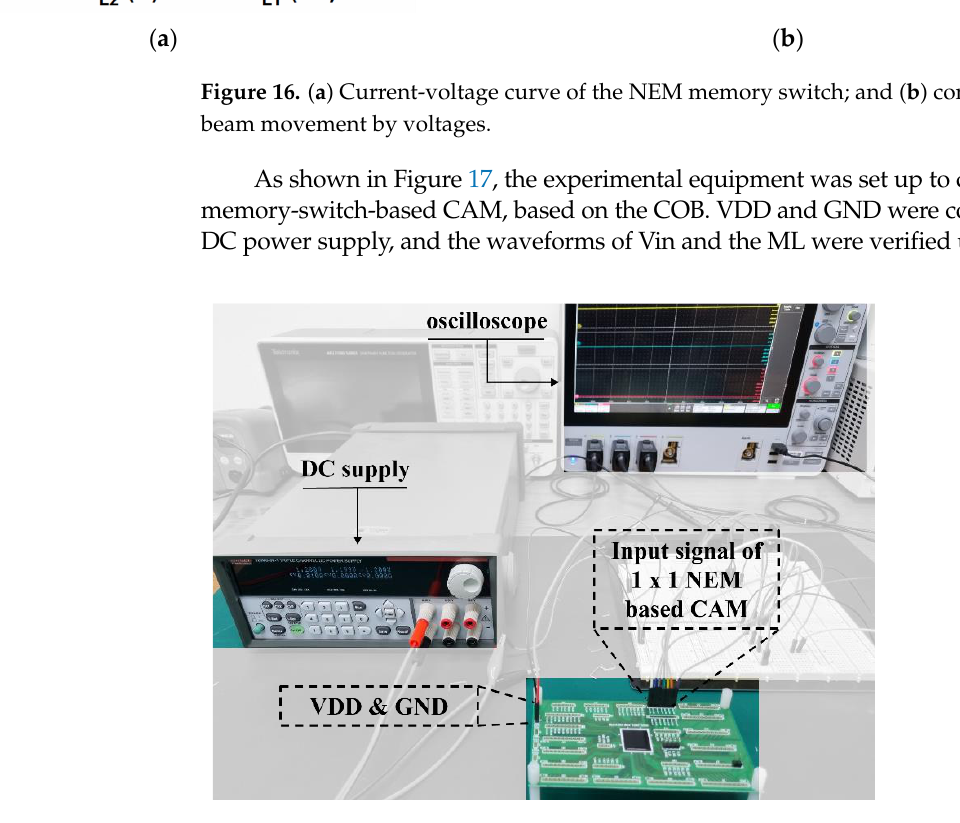
( b ) Figure 18. Timing waveforms confirmed by oscilloscope of 1 × 1 NEM-based CAM, where a ‘ 0 ’ value is written when searching. ( a ) ‘ 0 ’ results in a match and ( b ) ‘ 1 ’ results in a mismatch. Conversely, in the case of a mismatch, the search operation was started at the same time a ‘ 1 ’ was applied to the SL. While the ML maintains a high state, a pull-down path is formed, owing to the grounding of the NEM-based CAM cell. As a result, a low value is output, indicating a mismatch, as shown in Figure 18b. We confirmed that the operation results of the fabricated chip are the same as those of the simulation, thereby demonstrat- ing that the NEM memory-switch-based CAM can be applied in practice.